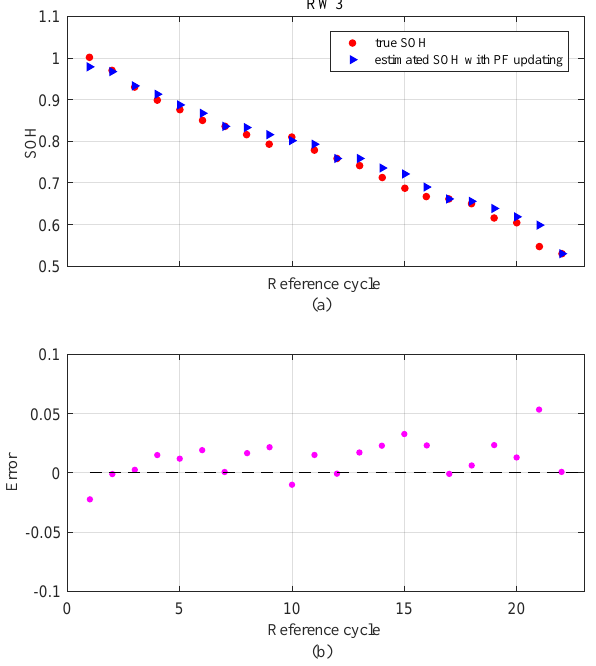
Figure 16. ( a ) SOH estimation results and ( b ) estimation errors for battery RW3 using indirect HIs with PF